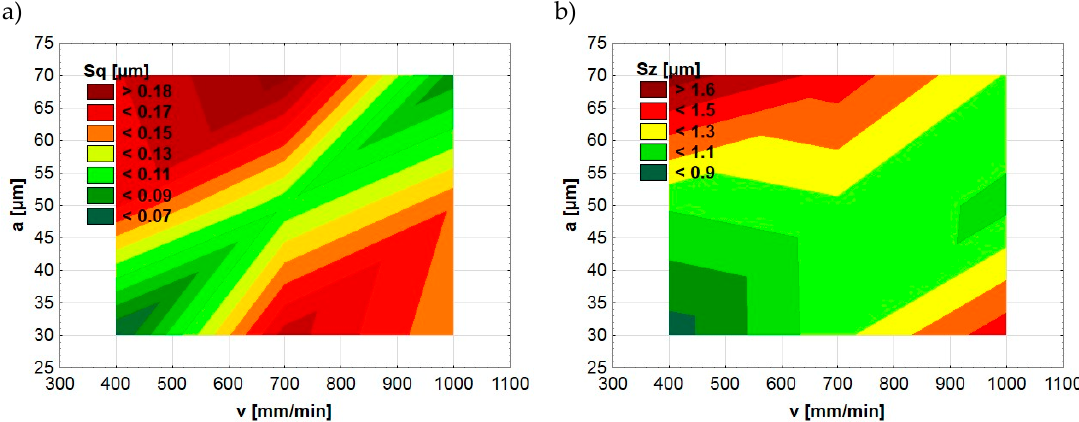
Figure 6. Dependence between ball-burnishing parameters ( v, a ) and surface topography parameters Sq ( a ), Sz ( b ).